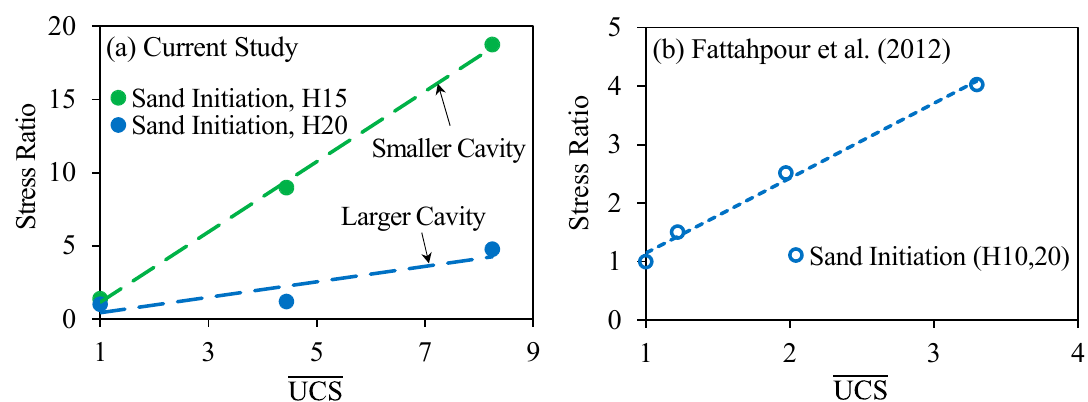
Figure 20. Variation of sand initiation stress level with sample strength in: ( a ) The current study; and ( b ) the experimental study of Fattahpour et al. [2].